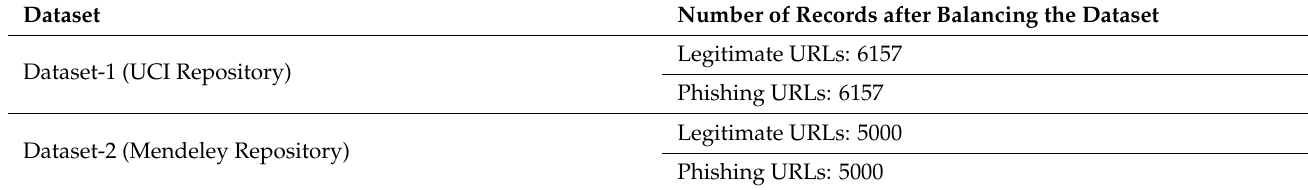
Table 9. Experiment dataset for Hyper-Parameter Tuning.